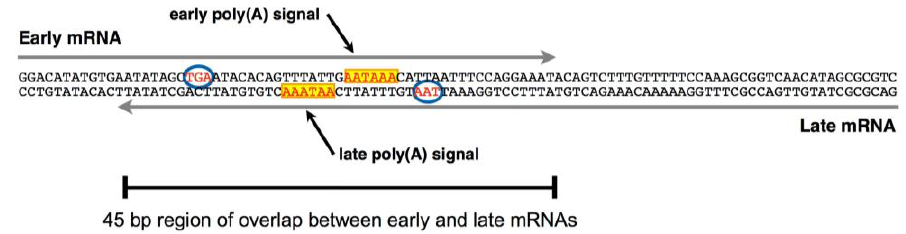
Figure 2. A crowded arrangement at the ends of the early and late genes. The sequence shown is of the 3′-region of the early and late transcription units, with the early coding strand on top and the stop codons for large T antigen and the virion structural protein VP1 circled. Note the overlap of the polyadenylation signals, including the canonical AATAAA elements (yellow box). Cleavage and polyadenylation occur downstream of these elements, leading to early and late mRNAs that have the potential to overlap for at least 45 base pairs (bp) at their 3′-ends. Transcript overlap is essential for the viral life cycle.